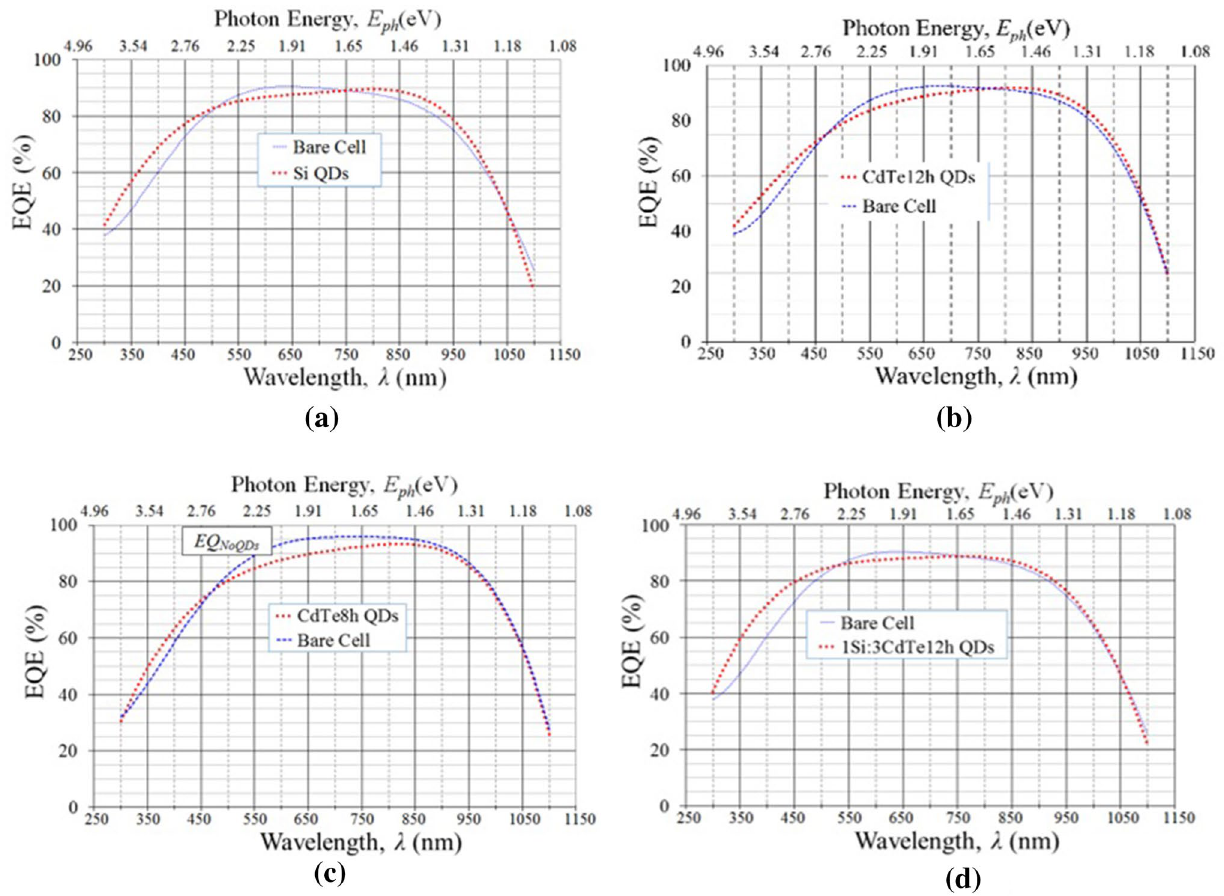
Fig. 4 EQE spectra of solar cells with and without Si and/or CdTe-12 h